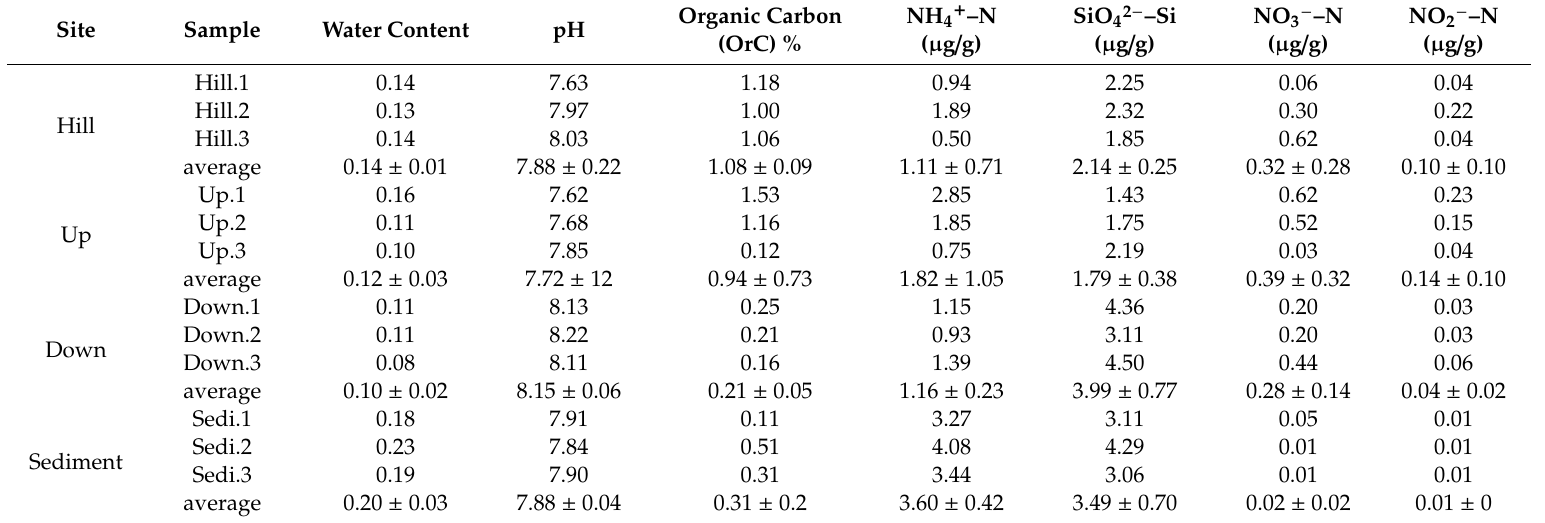
Table 1. Geochemical properties of the 12 samples investigated in the present